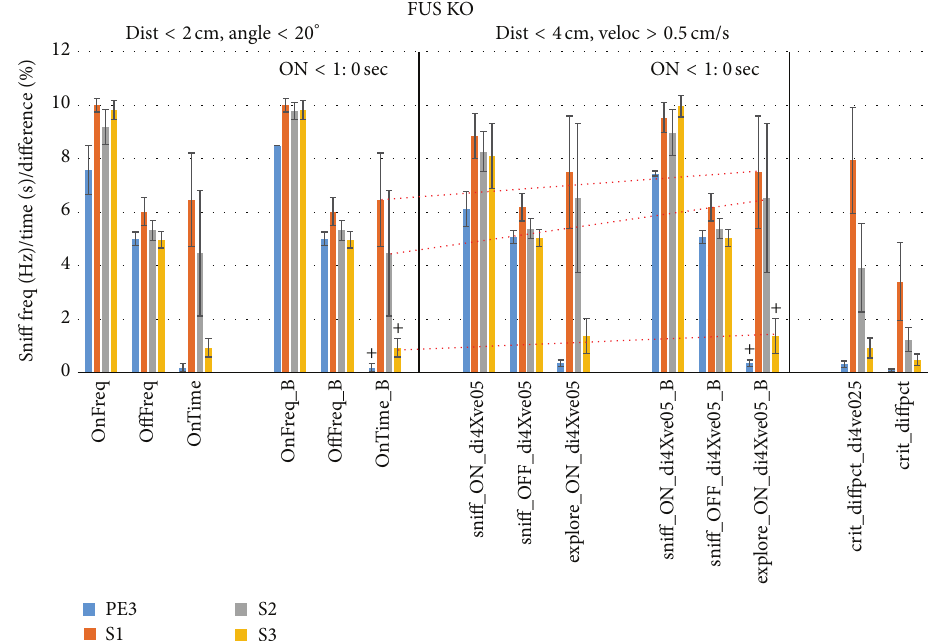
Figure 13: New combined proximity-velocity criterion improves HaXha exploration scoring in FUS KO mice. The same as Figure 12, but for FUS KO mice ( 𝑛 = 13 ). The new criterion increased S1, S2, and S3 exploration time (orange lines), while retaining high sniff rates indicative of sniff-guided odorant exploration. + 𝑃 < 0.01 (paired 1-sided 𝑡 -test versus S1).